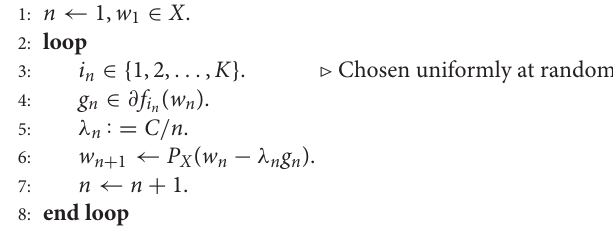
Algorithm 5: Pegasos (Shalev-Shwartz et al., 2011, Figure 1